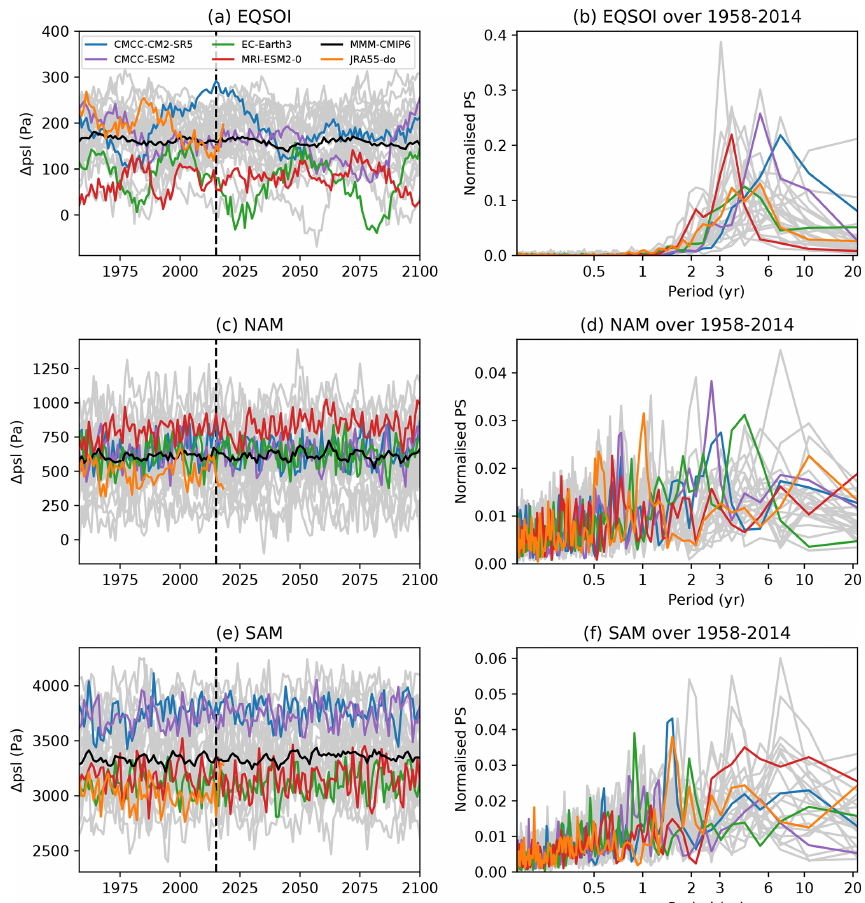
Figure 4. Comparisons of major climate modes simulated by 26 CMIP6 models over the historical period (1958–2014) and the projection period under the SSP5-8.5 scenario (2015–2100). Time series of annual mean sea level pressure difference between two regions representative of (a) EQSOI, (c) NAM, and (e) SAM. Normalized power spectra of (b) EQSOI, (d) NAM, and (f) SAM derived from time series of standardized monthly mean anomaly of sea level pressure difference over 1958–2014 based on Welch’s method (Welch, 1967). Blue, purple, green, and red denote 4 of the 24 models that provide the atmospheric output at the temporal resolutions needed for the projection experiment of IAMIP2. Grey denotes the remaining 22 models. Black denotes the multi-model mean of the 26 models. Orange denotes the JRA55-do dataset used for the atmospheric forcing for the historical experiment of